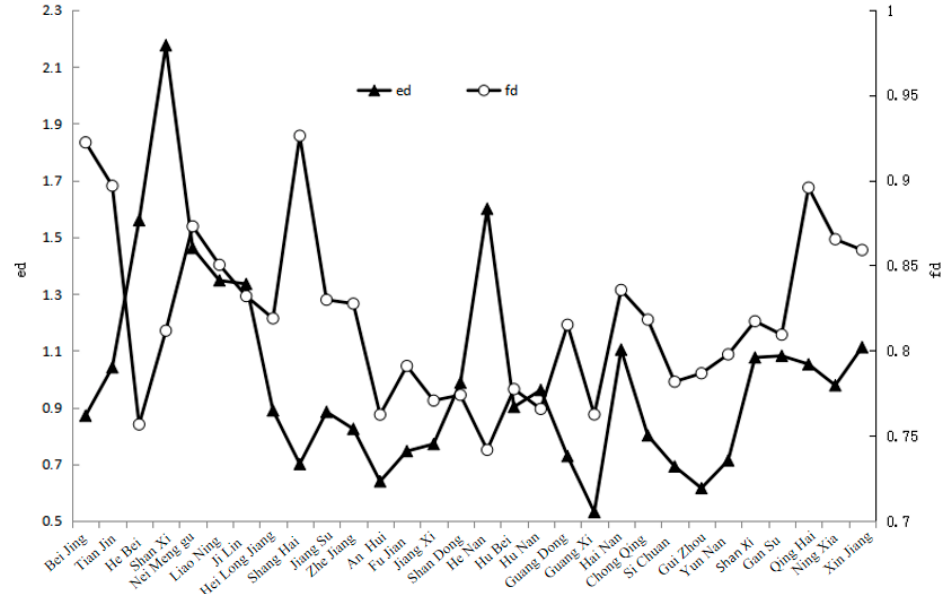
Figure 3. The levels of fiscal decentralization ( fd ) and environmental decentralization ( ed ) by region.